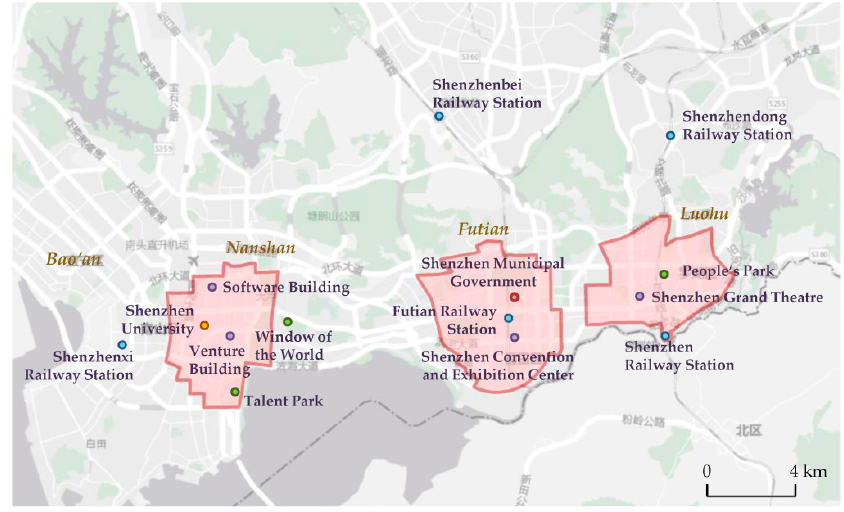
Figure 12. Analysis of the recognized center patterns in Shenzhen.